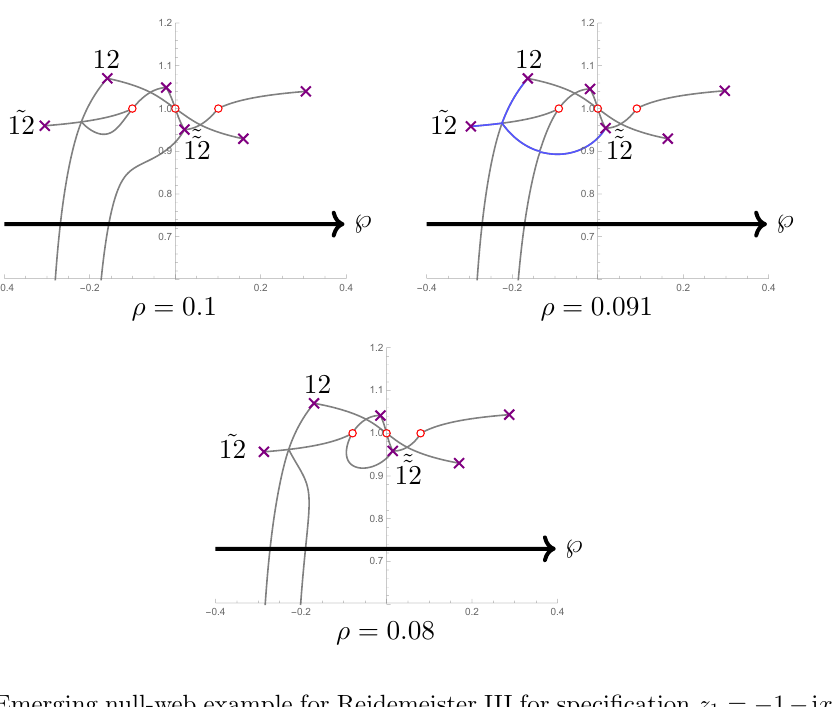
1 i x , z 2 = i (cid:26) , (cid:0) (cid:0)